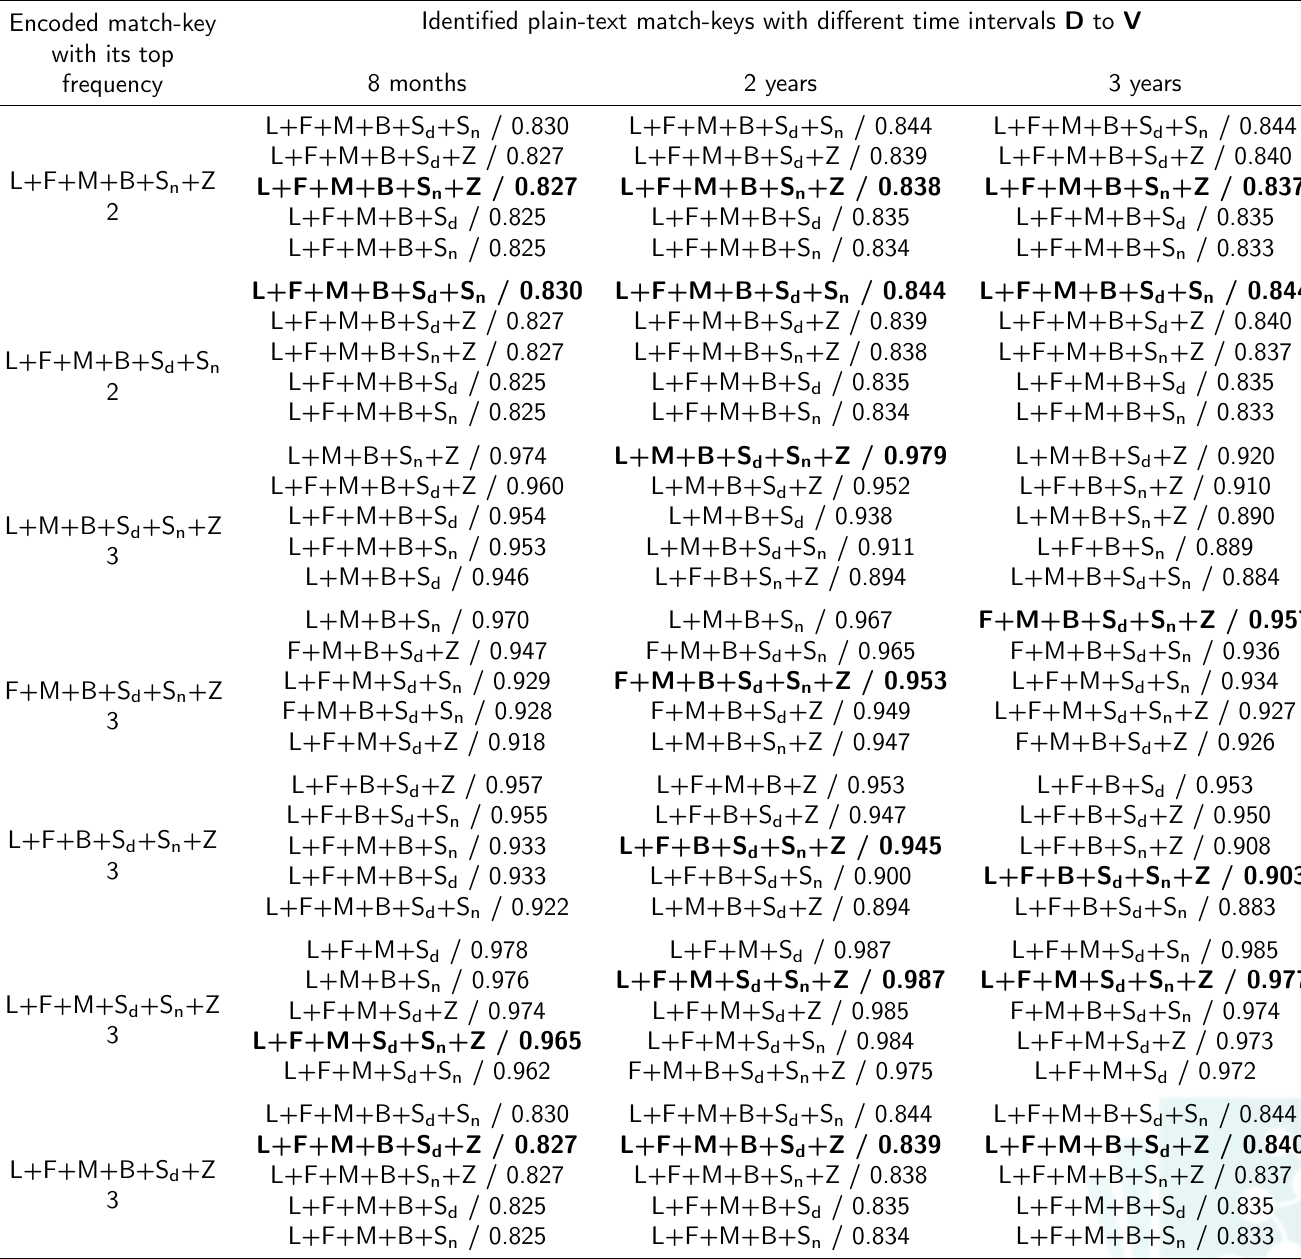
), StreetName (S ), and ZipCode (Z). We d n value of each plain-text match-key. c